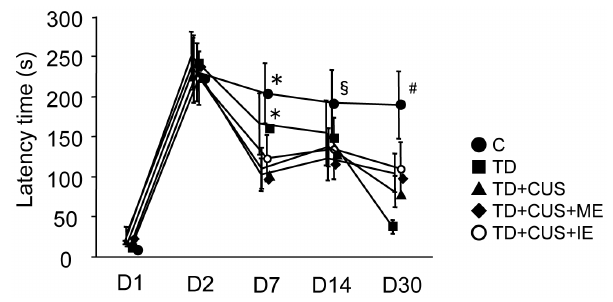
Figure 6. Effects of tryptophan deficiency, CUS and regular exercise on latency time to re-enter a dark compartment in the passive avoidance test. Data are expressed as mean 6 SEM. *, p , 0.05 vs. TD + CUS, TD + CUS + IE; 1 , p , 0.05 vs. TD + CUS + IE; # , p , 0.05 vs. TD, TD + CUS, TD + CUS + ME, TD + CUS + IE.